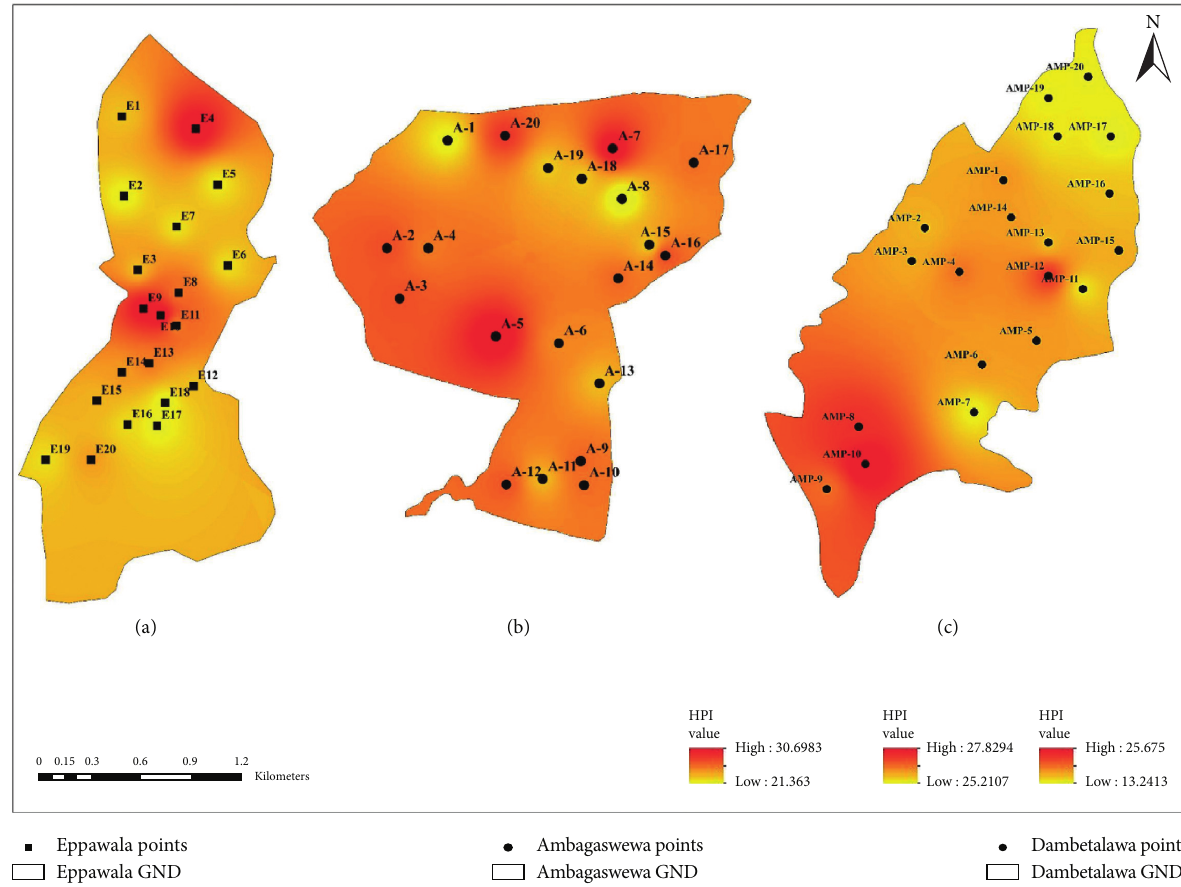
Figure 2: Interpolation of heavy metal pollution index (HPI) in sampling location via drinking water analysis: (a) Eppawala GND in